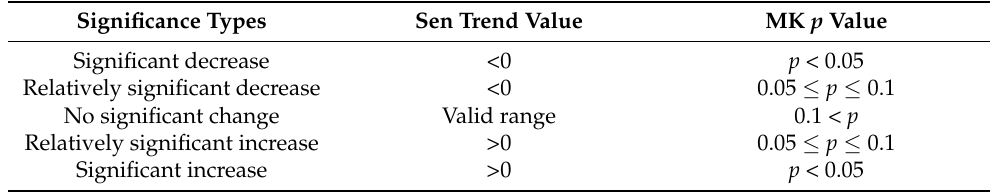
Table 3. Significance test of the trend of